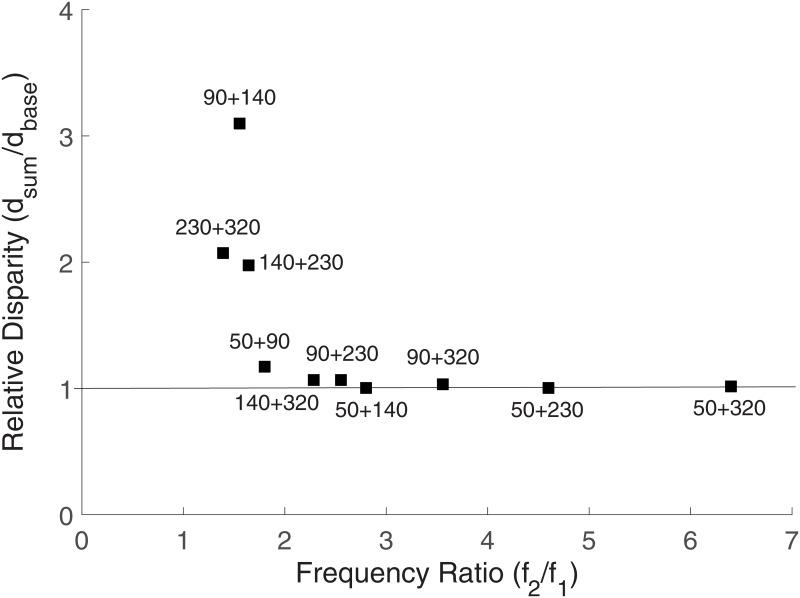
Frequency ratio (f2/f1) vs. dsum/dbase of the ten dual-frequency vibration stimuli in Experiment II.